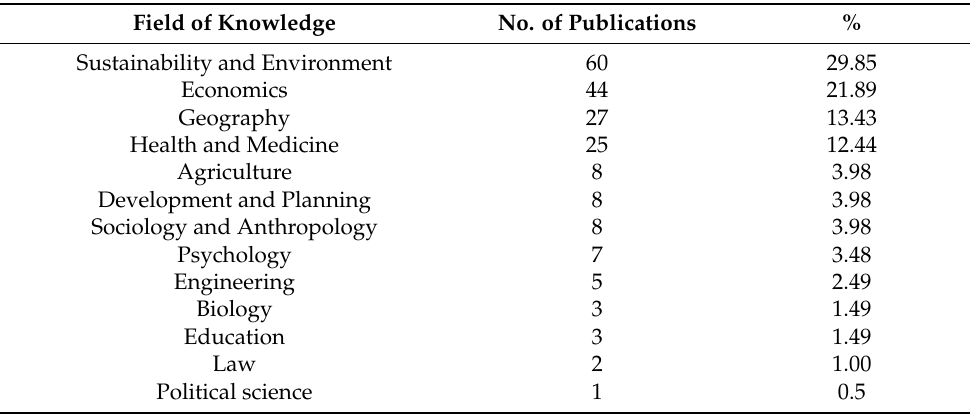
Table 4. Publications by field of knowledge.